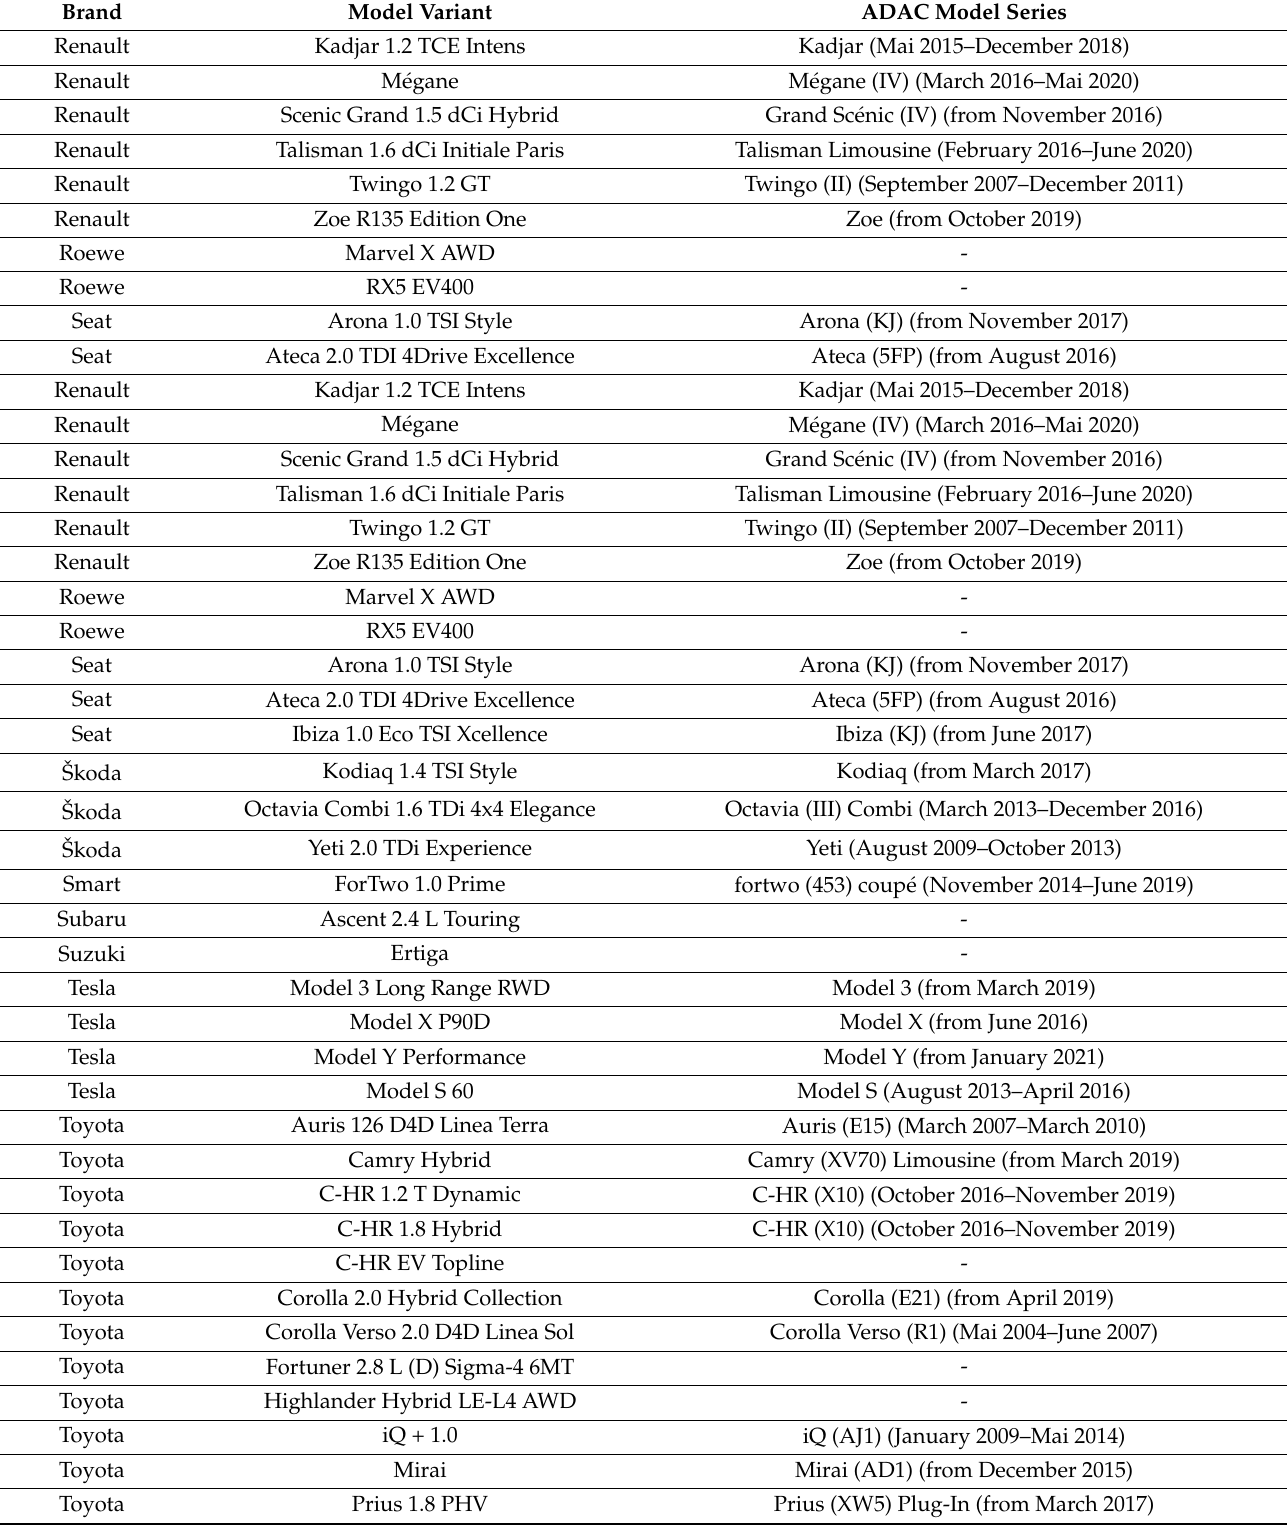
Table A14. Overview of the employed vehicles for the parametric mass model (Part